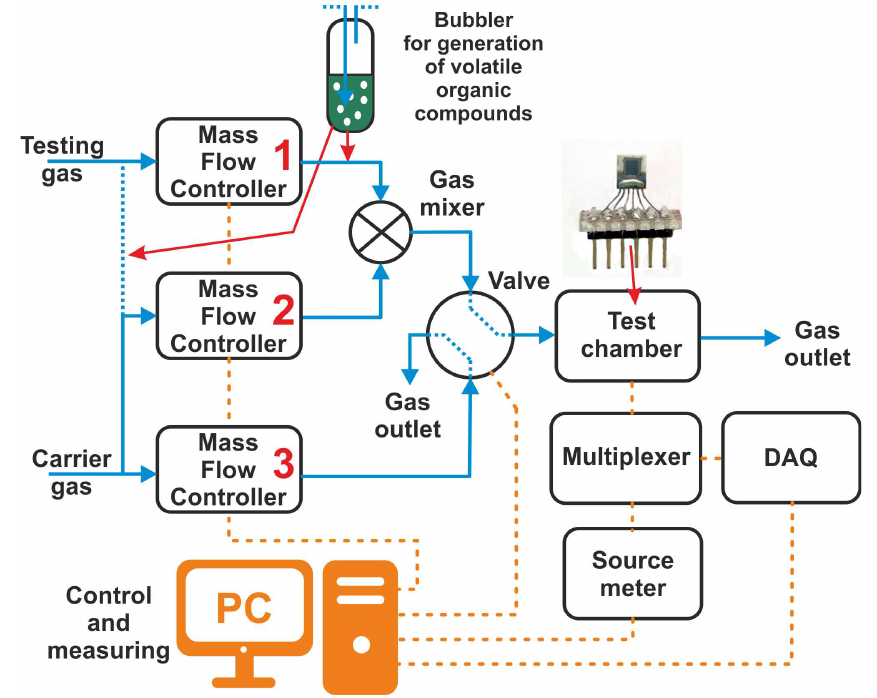
Figure 5. Schematic diagram of the gas sensing characterizations apparatus.